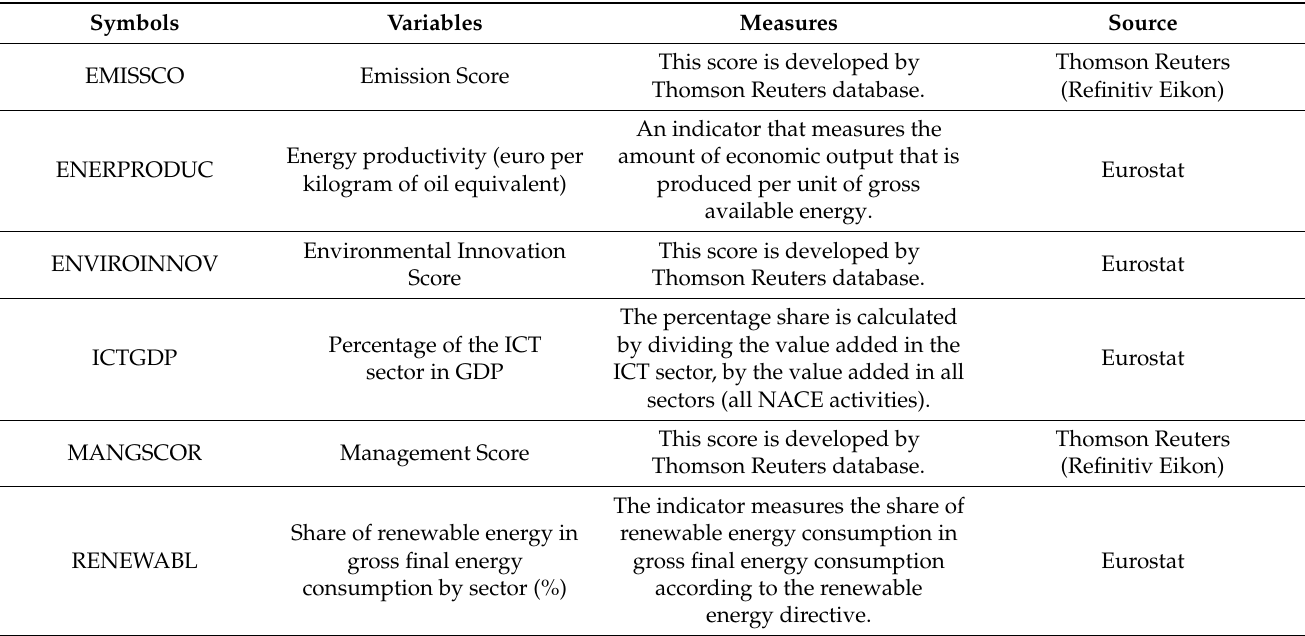
Table 2. Variables of the study. Source: Own elaboration.